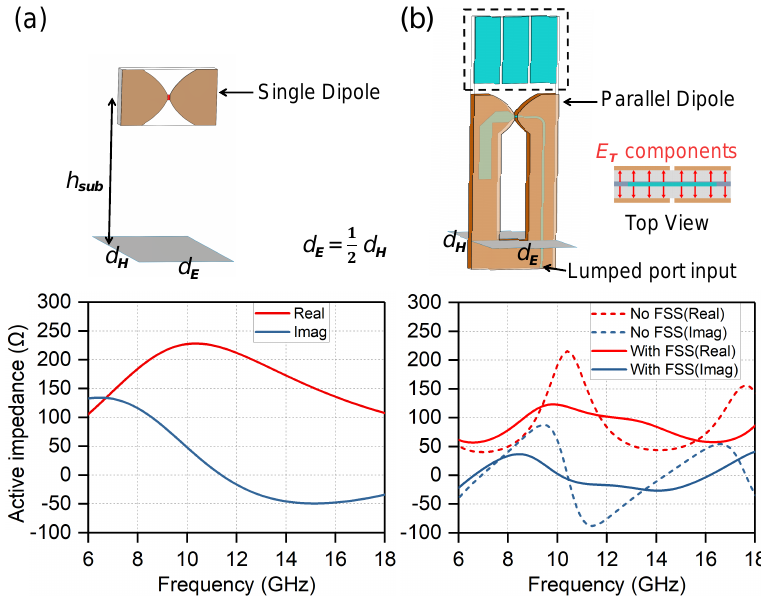
Figure 4. Active impedance analysis of the unit cell with periodic boundary condition using full-wave simulation software. ( a ) Single-dipole element; ( b ) Parallel-dipole element with a Marchand